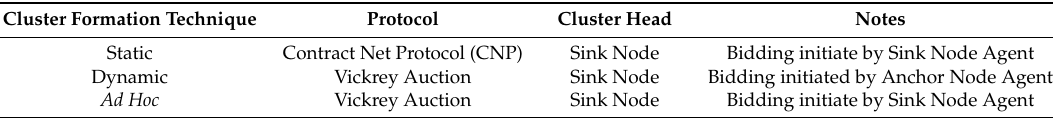
Table 2. Cluster formation